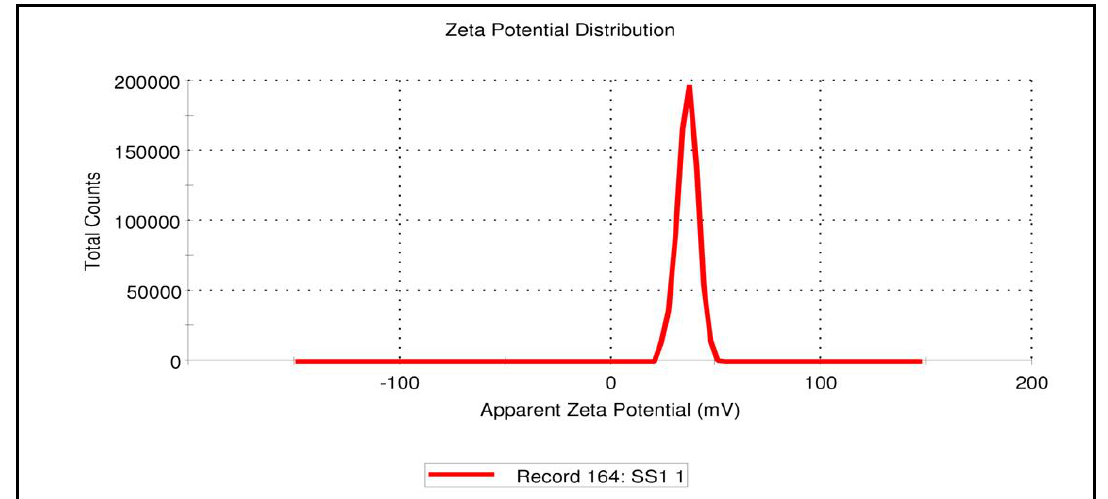
Figure 7. Size and size distribution curve of SGN–TC nanoparticles (F3).